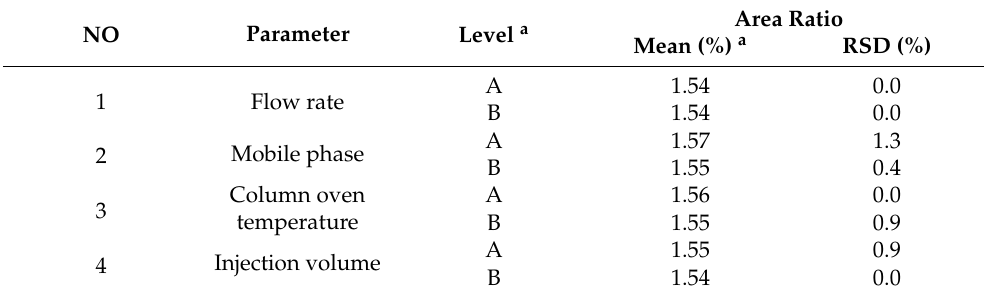
Table 3. The robustness of the